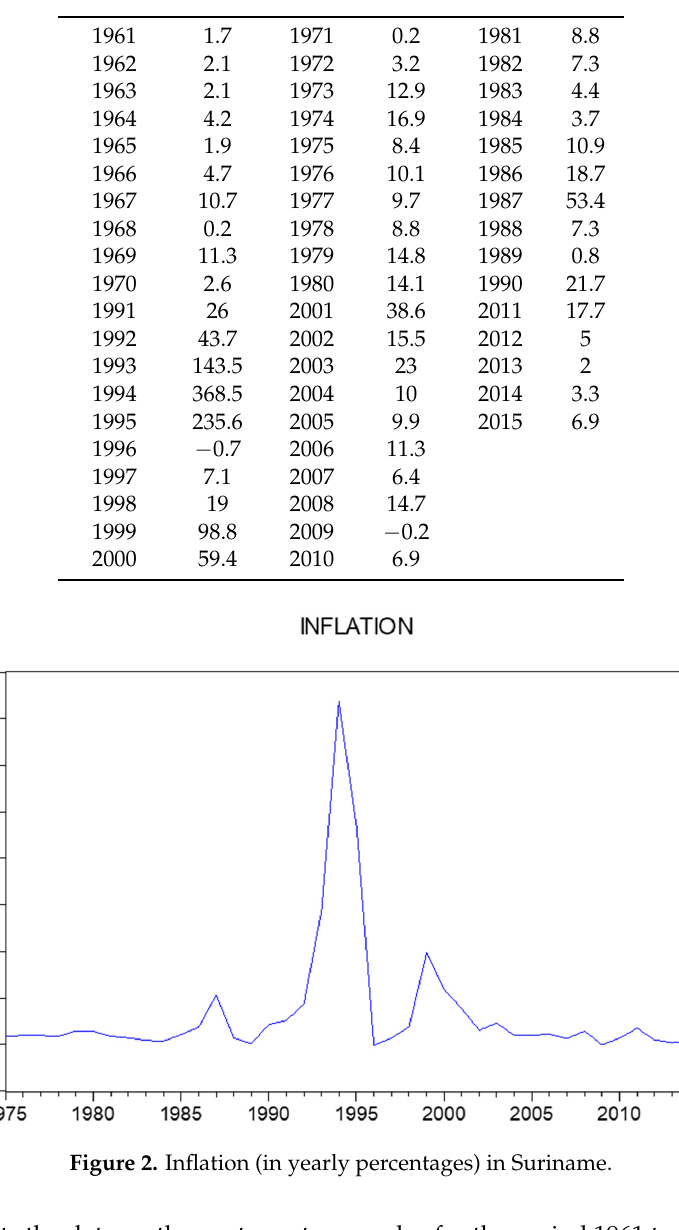
Table 1. Inflation data. All items index annual average (source: World Bank).